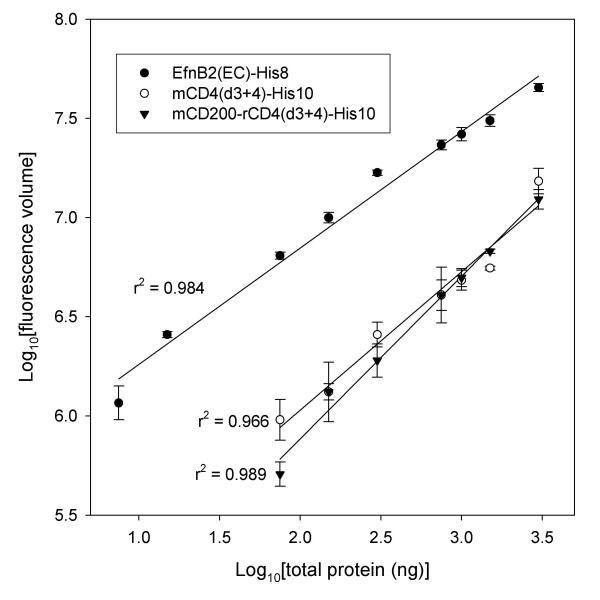
Dot blot calibration curves using three standard proteins. Three purified proteins (quantitated by SEC) diluted in mock supernatant and denatured by addition of urea to a final concentration of 5 M were analysed within a range of 0 to 3000 ng per dot by dot blot. R2 were calculated by linear regression analysis (SigmaPlot, SPSS Inc). Error bars represent standard deviations calculated from the data (n = 3).